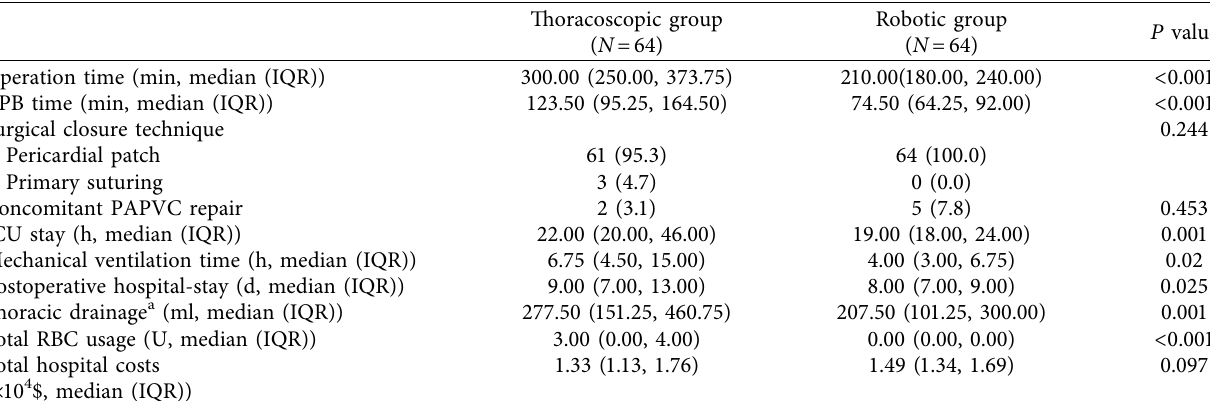
Table 3: Perioperative details (propensity-matched groups).